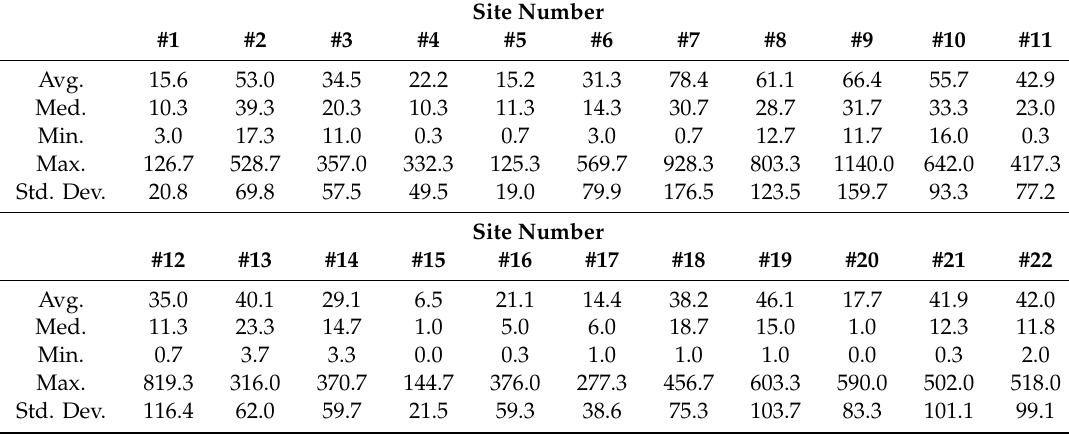
Table 2. Descriptive statistics of suspended particulate matter (mg L − 1 ) at each sampling location (n = 22) during the study period (2 January 2018–1 January 2019) in West Run Watershed, WV, USA. Note: all average values presented in the current work constitute arithmetic